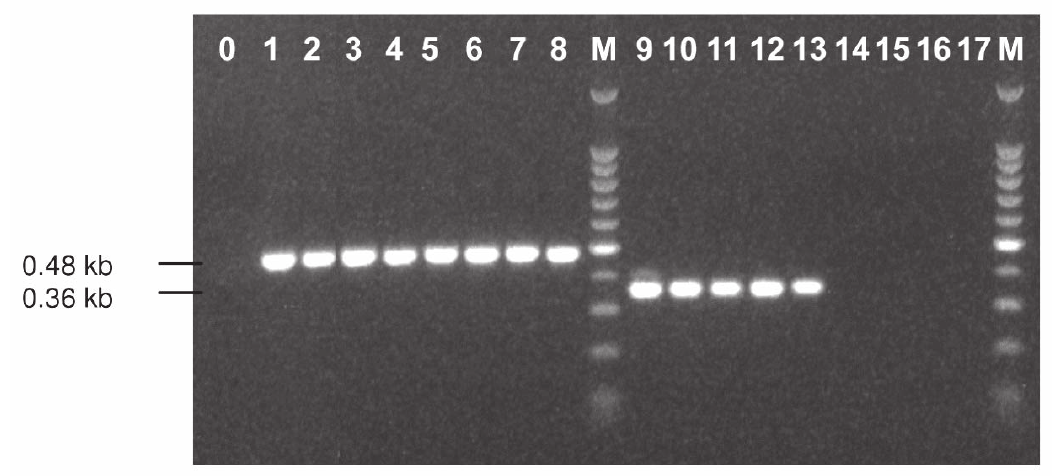
Fig. 2. PCR amplification using primers Bc 108+ and Bc 563– on 1 ng Botrytis cinerea genomic DNA of grey strains B23 (1), B190 (2), B192 (3), B194 (4), B197 (5), B199 (6), B201 (7), B203 (8), and of yellow strains B189 (9), B193 (10), B198 (11), B200 (12) and B204 (13). Botrytis allii isolate B195 (14); B202 (15); B. fabae Bfa2 (16), Fusarium sp. F8 (17). Lane 0, negative control (no DNA); Lane M, molecular weight marker (100 bp DNA ladder,